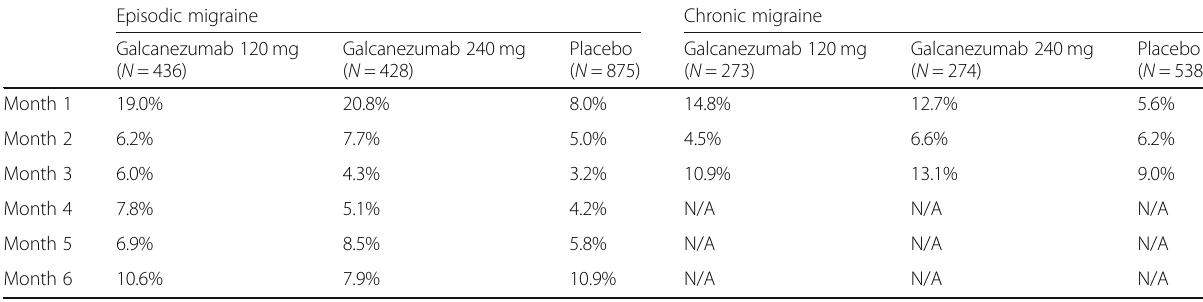
Table 4 Onset of 50% maintenance of response in patients with episodic and chronic migraine: percentage of patients reach 50% response at each month and all the subsequent months